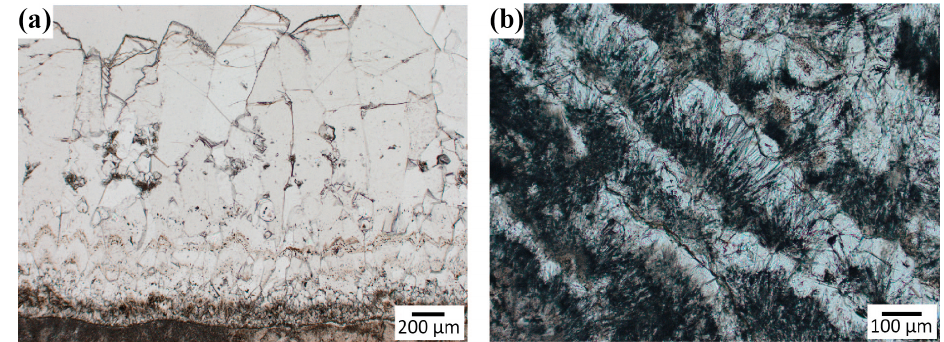
Figure 4. Petrography of the carbonate crusts. (a) Primary columnar calcite crystals growing perpendicularly to the substrate on the steeper side of the bedrock irregularity; (b) alternation of aragonite (fibrous) and calcite crystals forming layered textures. The base of the aragonite fans of crystals nucleates in dark micritic aggregates. Both images were taken under plane-polarised